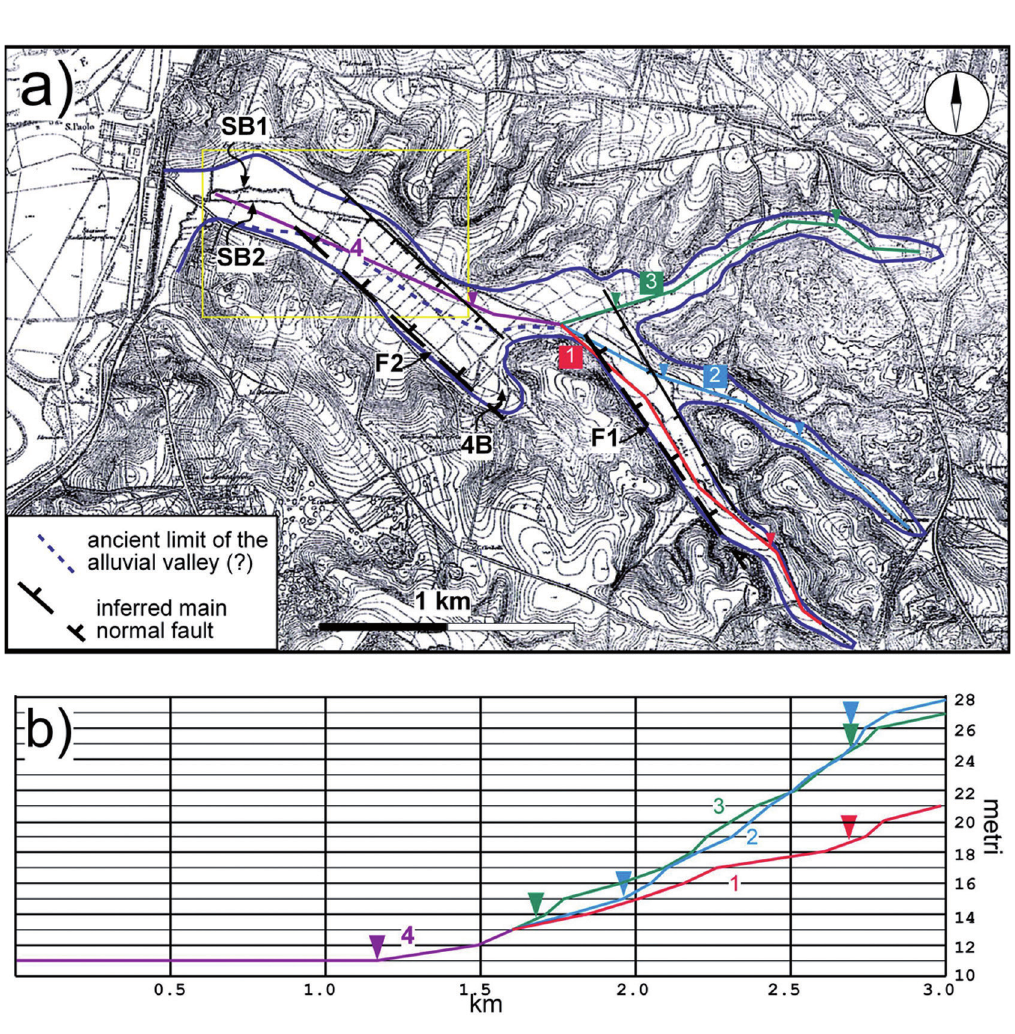
Fig. 2a,b. The Grottaperfetta alluvial valley and the inferred fault traces bounding the south western edge (F1 and F2); rectangle includes the area enlarged in fig. 3. SB1 and SB2 indicate two convergent stream-beds. The profiles referred to different sectors of the alluvial valley are numbered as 1, 2, 3, 4 and 4B and reported in fig. 2b. Coloured triangles mark the sharp vertical changes occurring along the